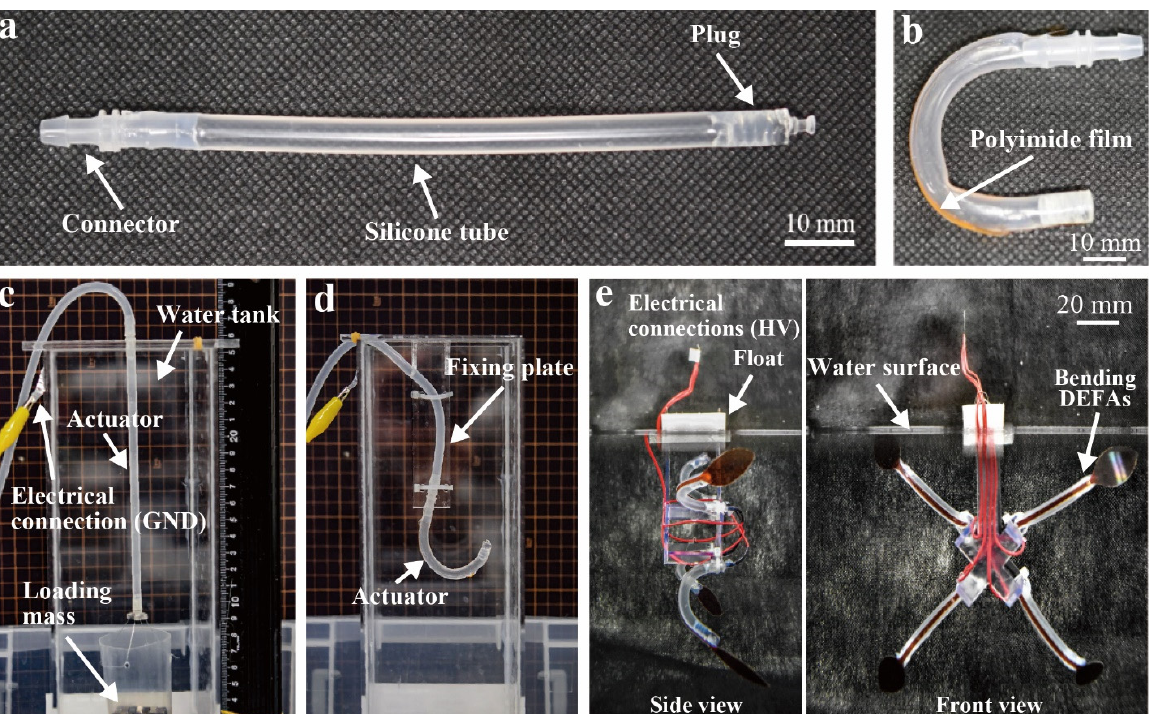
Figure 3. ( a ) Fabricated linear-type DEFA (without aqueous electrode). ( b ) Fabricated bending-type DEFA (without aque- ous electrode). ( c ) Experimental setup to characterize linear-type DEFA and ( d ) bending-type DEFA. ( e ) Jellyfish-type underwater robot using four bending-type